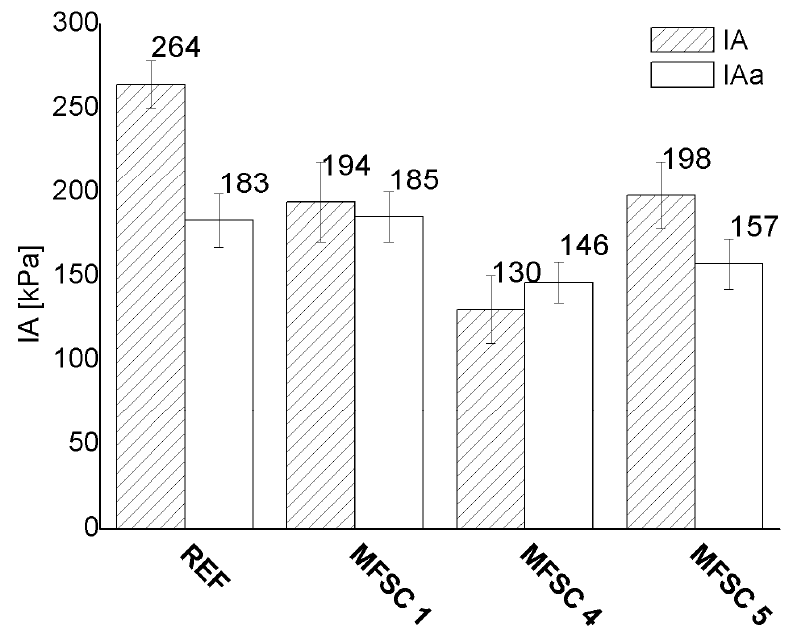
Figure 3. The comparison of ice adhesion before and after exposure in an aging chamber.